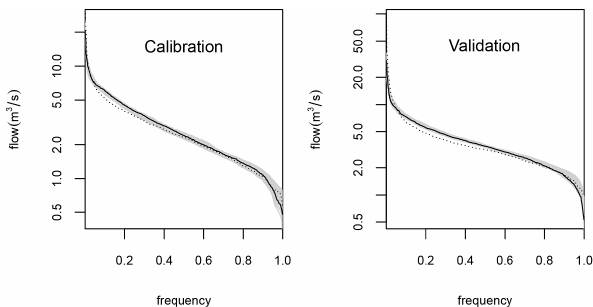
Figure 8. Flow duration curve for observations (dotted line), and simulated with MOO (grey) and SOO (solid line).